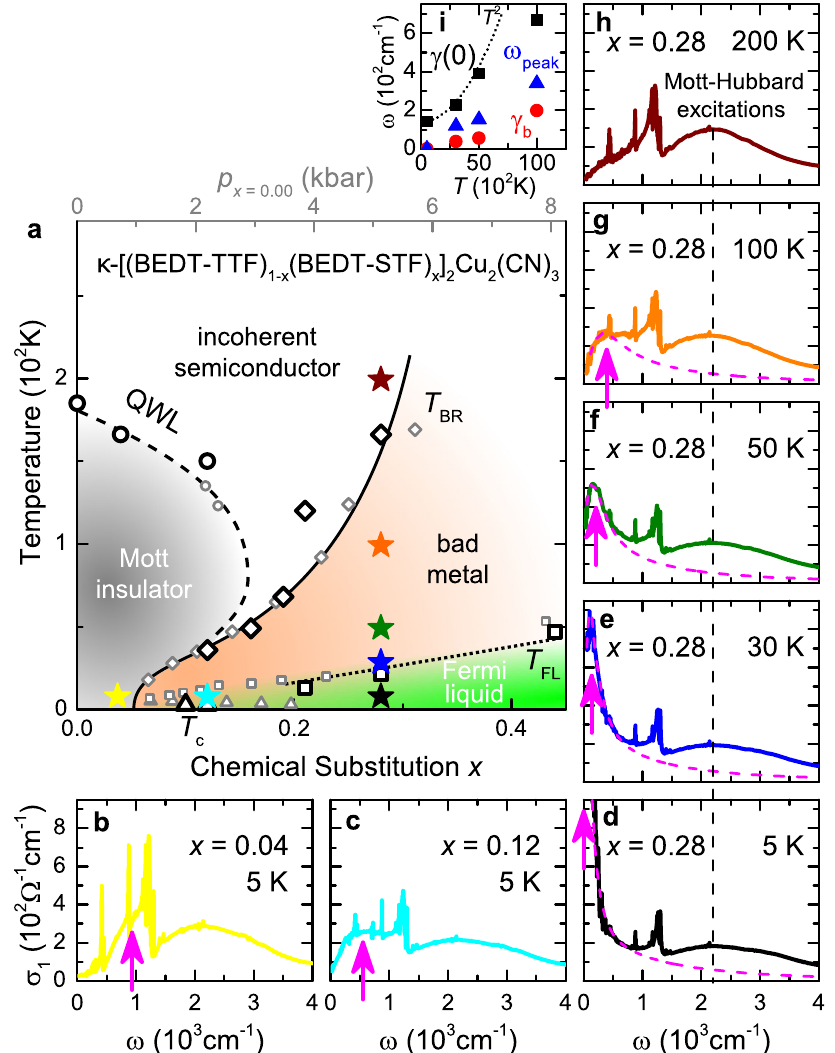
Fig. 4 Displaced Drude peak linked to bad metal. a Chemical substitution x (black symbols) and physical pressure p (gray, see Supplementary Fig. 2) have the same effect on κ -(BEDT-TTF) 2 Cu 2 (CN) 3 24 . b – h Evolution of σ 1 ( T , ω , x ) through the phase diagram; stars with respective color indicate the position in a . Entering the bad-metallic phase for T > T FL shifts the Drude peak away from ω = 0. The maximum broadens and hardens with T , until it dissolves at T BR . Approaching the insulator ( x = 0.28 → 0.04) at low T , the QP feature transforms into fi nite-frequency metallic fl uctuations within the Mott gap 13 . i Fit parameters (Eq. (2)) for dashed pink lines in d – g and Fig. 3a, b. Dotted line indicates γ ð 0 Þ ¼ γ þ B ð p π k B T = _ Þ 2 , with B and p from 0